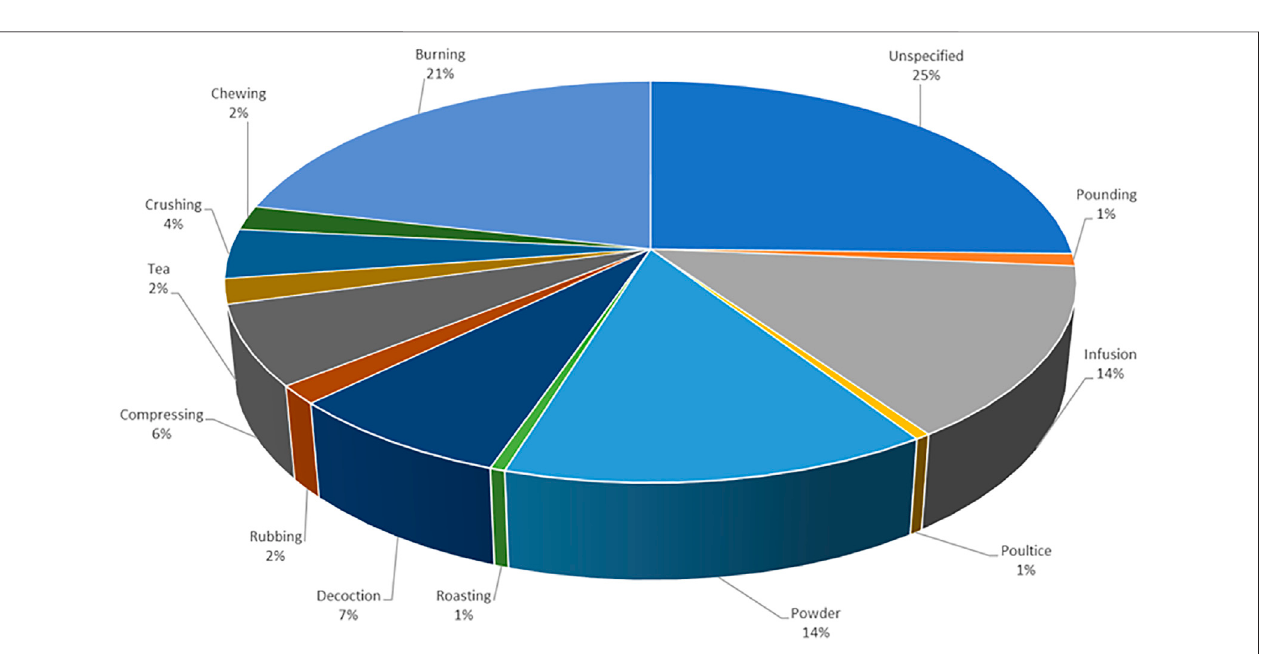
Frontiers in Pharmacology |